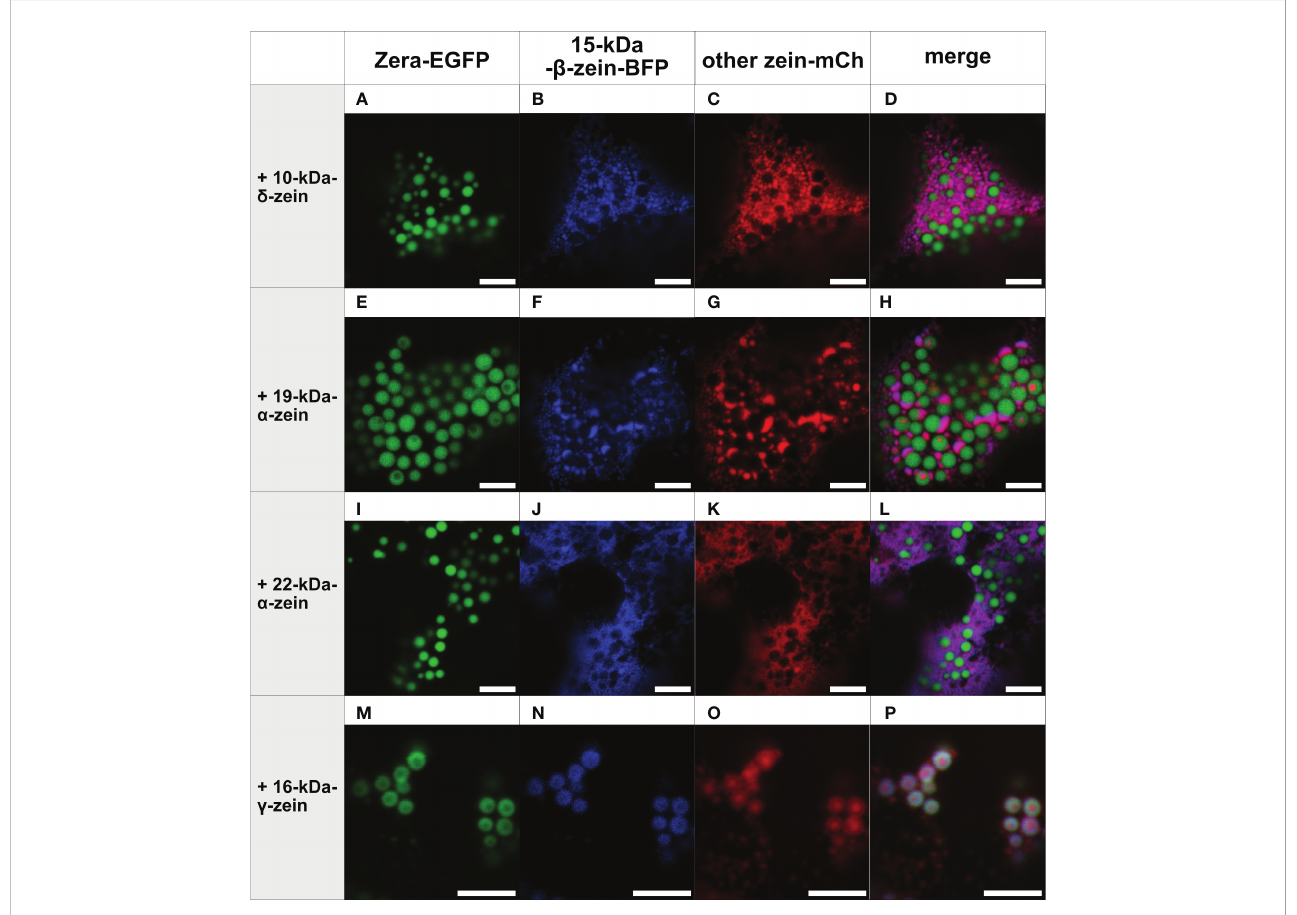
FIGURE 2 Co-expression of Zera-EGFP and 15-kDa- b -zein-BFP together with a third zein component fused to mCherry (representative images recorded with confocal laser scanning microscopy). First panel: Zera-EGFP; second panel: 15-kDa- b -zein-BFP; third panel: mCherry-fusion of the zeins listed on the left; fourth panel: overlay images. (A-D) Zera-EGFP + 15-kDa- b -zein -BFP +10-kDa- d -zein-mCherry, (E-H) Zera-EGFP + 15-kDa- b -zein -BFP + 19-kDa- a -zein-mCherry, (I-L) Zera-EGFP + 15-kDa- b -zein -BFP + 22-kDa- a -zein -mCherry, (M-P) Zera-EGFP + 15-kDa- b -zein -BFP + 16-kDa- g -zein-mCherry. Scale bar 5